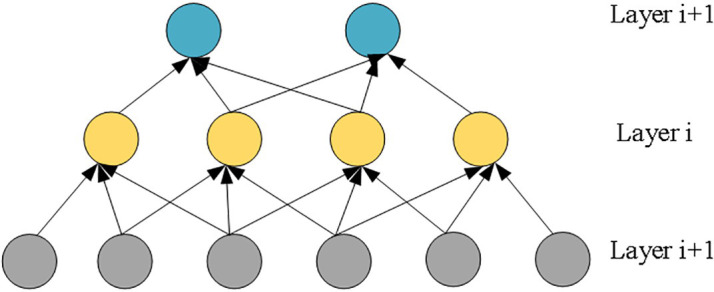
Schematic diagram of local perception based on CNN.